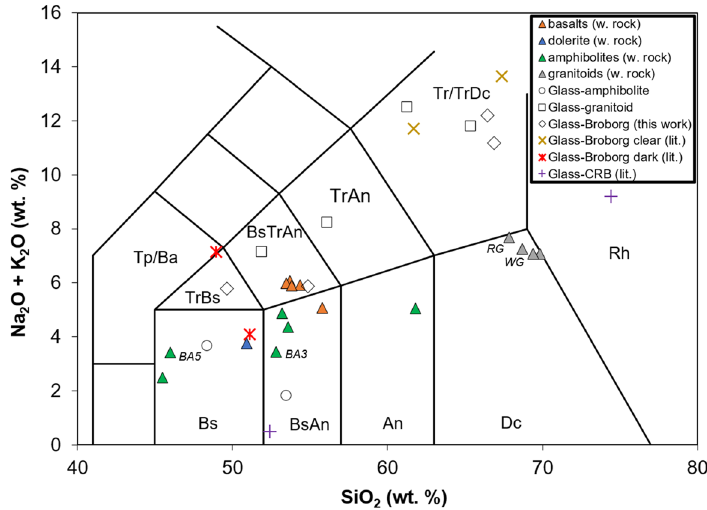
Figure 9. Compositional space of considered whole rocks (triangles) including basalts, dolerite, granitoids, and amphibolites, several of which are labeled, as well as measured glass compositions from this work (open symbols) and literature (other symbols) as shown in Table 1. Diagram based on the total alkali silica (TAS) diagram of Le Maitre et al. 61 for volcanic rocks. Regions of TAS relevant to the data are: Basalt (Bs), Basaltic Andesite (BsAn), Andesite (An), Dacite (Dc), Trachyte/Trachydacite (Tr/TrDc), Trachyandesite (TrAn), Basaltic Trachyandesite (BsTrAn), Trachybasalt (TrBs), Tephrite/Basanite (Tp/Ba).